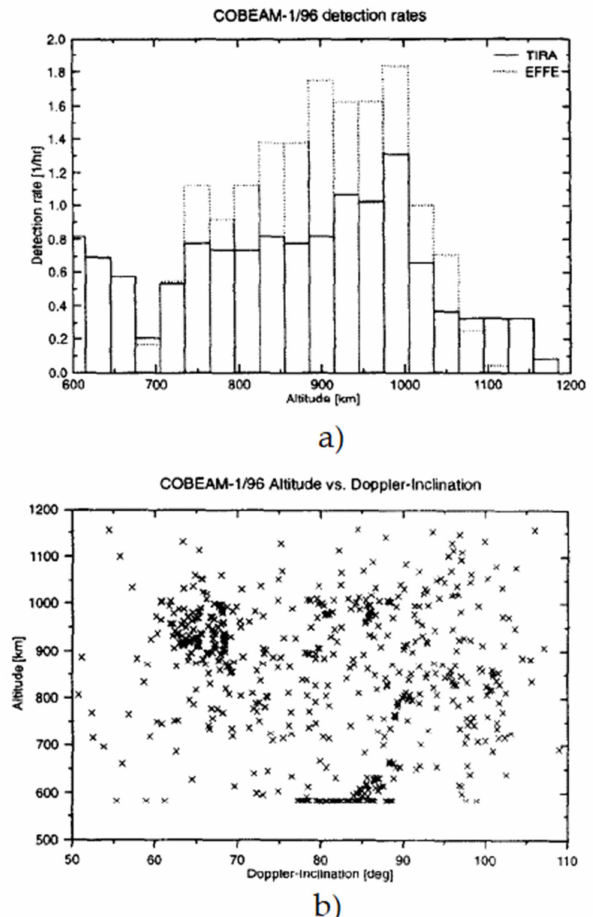
Figure 20. Detection rate vs. altitude for the monostatic and bistatic configuration ( a ) and altitude vs. Doppler inclination ( b ) for the 1996 COBEAM experiment [38]. Reprinted from Advances in Space Research, Copyright 1999, with permission from